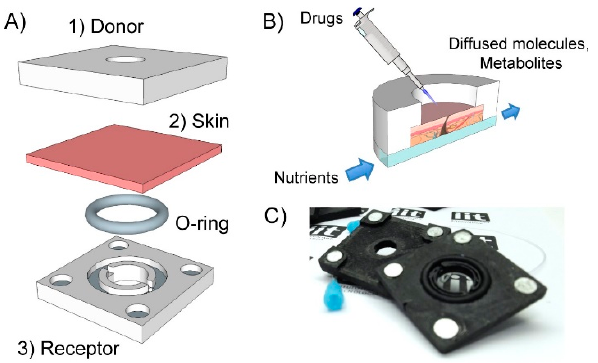
Figure 1. ( A ) Schematic of the 3D-PDC that consists of three parts: (1) the receptor chamber, integrating two channels and a glass window; (2) the skin tissue and (3) the donor chamber. An O-ring inserted under the skin seals the receptor and prevents leakage of liquids. Both components integrate 4 magnets to ease the assembling procedure. ( B ) 3D-PDC operational principle. Drug delivery systems (liquids, creams) can be directly applied to the epidermis through the donor. Two microchannels allow sampling of the receptor solution. ( C ) Photograph of the donor and receptor parts (3D-PDC size 1 cm × 3.5 cm × 3.5